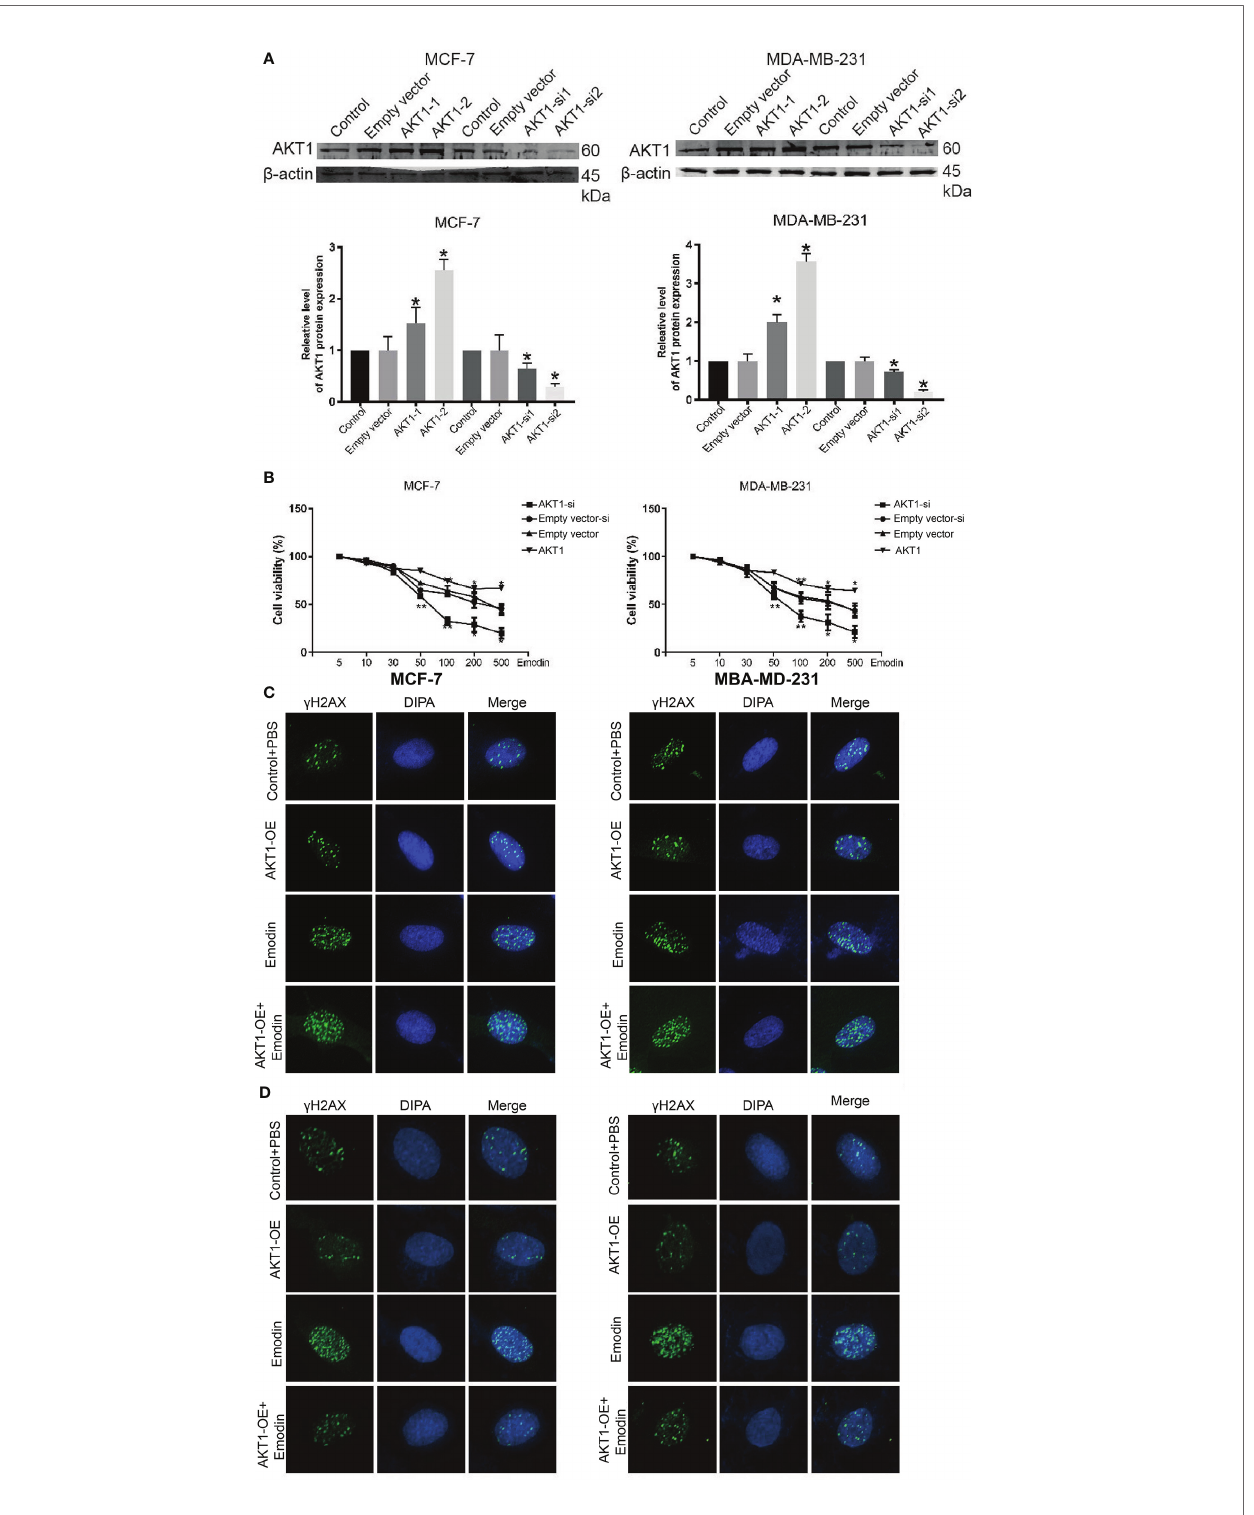
FIGURE 7 | BC cells complemented with AKT-1-si or AKT-1-oe regulated to Emodin. (A) The expression of AKT1 after treatment with AKT1-siRNA or AKT1 over- expression. (B) CCK-8 assay shows the BC cells complemented with AKT1-siRNA or AKT1 over-expression. (C) DNA damage assays shows that the BC cells complemented with AKT1-siRNA promote Emodin compared with cells treated with AKT1-siRNA or Emodin alone. (D) DNA damage assays shows that the BC cells complemented with AKT1 over-expression resists Emodin compared with cells treated with AKT1-overexpression or Emodin alone. The analysis was conducted using the Student ’ s t-test. p > 0.05, ** p < 0.01, * p <